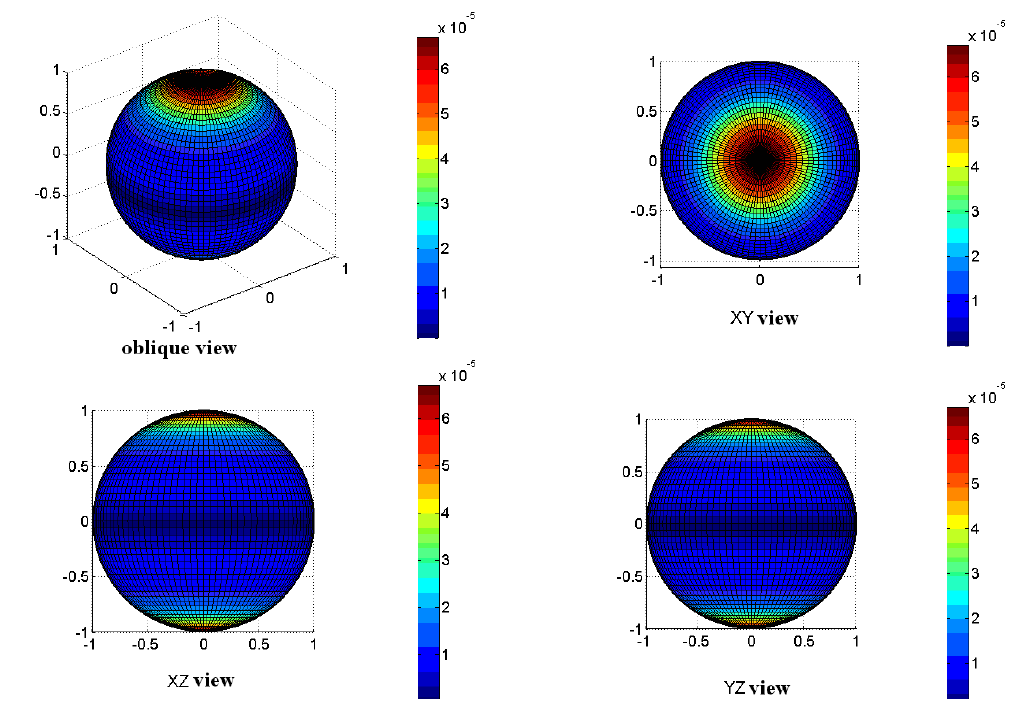
Figure 9. The distribution of on the sphere surface.